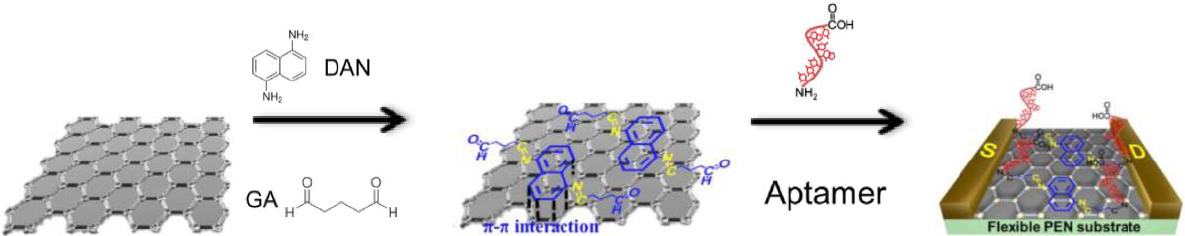
Figure 6. The mercury(II) ion sensing principle scheme with the use of liquid-ion gated field effect transistor (FET) transducer. Adapted with permission from An et al. [59] (Copyright © (2013) ACS).